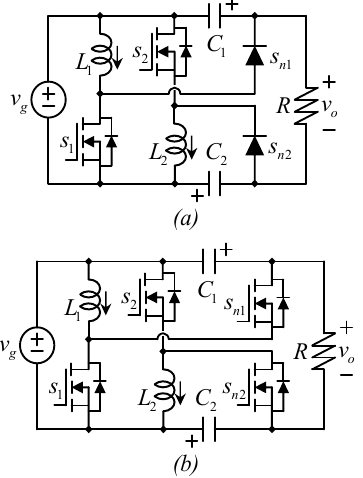
Figure 2. Proposed circuit: ( a ) unidirectional power flow and ( b ) bidirectional power flow.